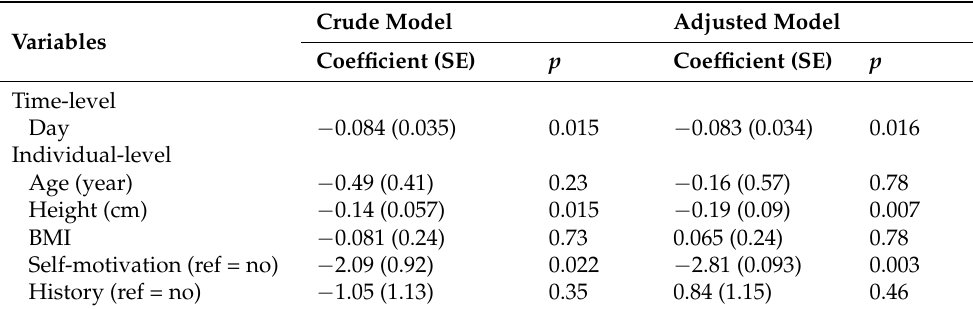
Table 3. Adjusted mixed effects of multi-level regression model for salivary oxytocin level (pg/mg) during the one-month summer camp ( n of bushcraft survival challenges [level 1] = 2, n of observations [level 2] = 180, n of the individuals [level 3] =